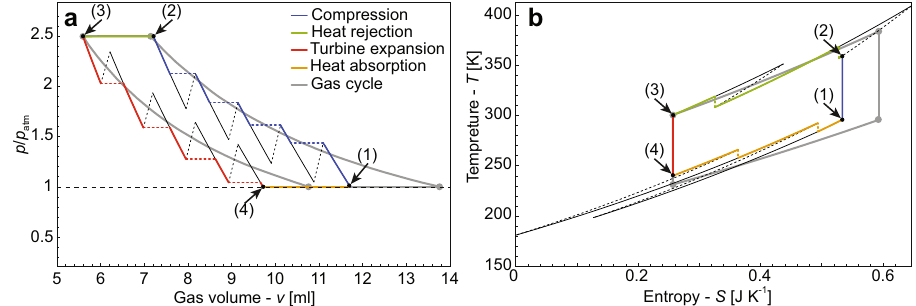
Fig. 5 Refrigeration cycles simulations of a meta fl uid compared with gas only. a Pressure volume diagram of a meta fl uid cycle, transition between states 1-2, 2-3, 3-4, and 4-1 denoted by black green, red, and orange lines, respectively, and air cycle denoted by gray lines. b show a temperature-entropy diagram. The blue, green, red, and orange lines in Fig. 5 correspond to meta fl uid transitions 1-2, 2-3,